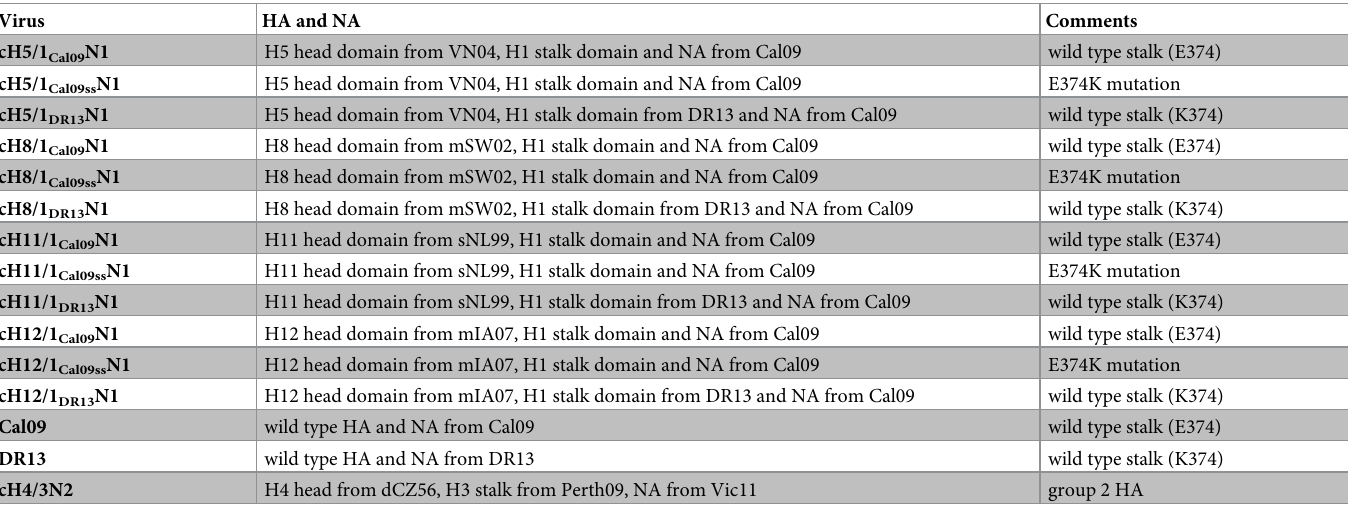
Table 1. Viruses tested for stability during storage at 4˚C and 27˚C. Virus HA and